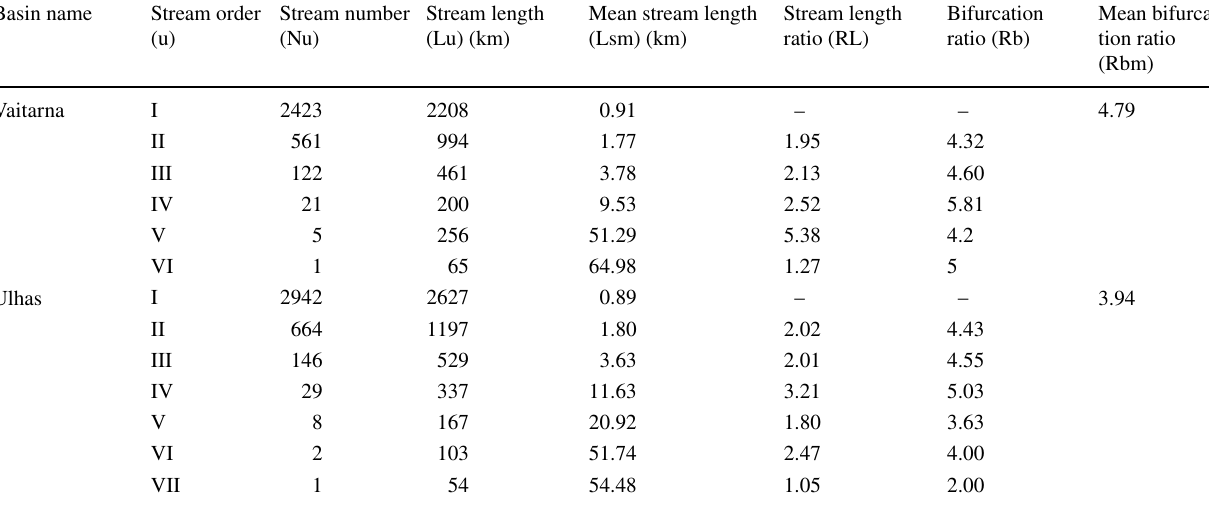
Table 2 Results of drainage network properties in Vaitarna and Ulhas basins Basin